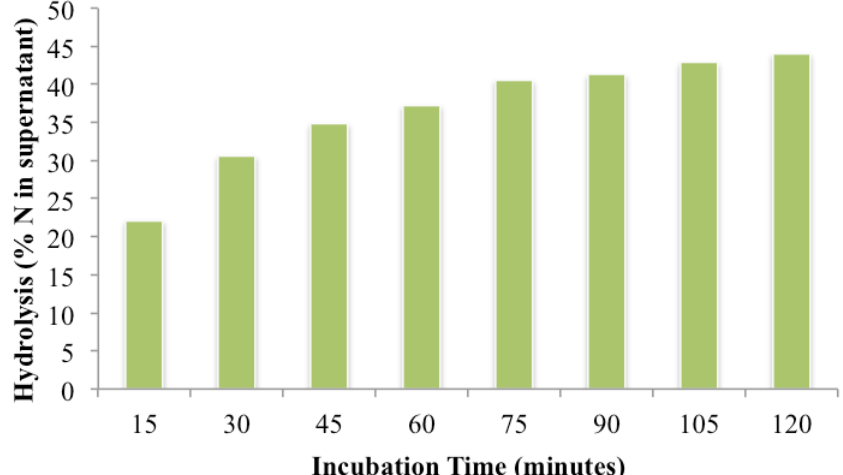
Figure 2. Effect of incubation-time on hydrolysis of FDM (freeze dried meat) by KF (kiwifruit protease) measured by the percentage of ammoniacal nitrogen in the supernatant of the hydrolysate. The reaction mixtures contained 600 mg FDM, 20 mL of 0.022M HCl and 100 mg